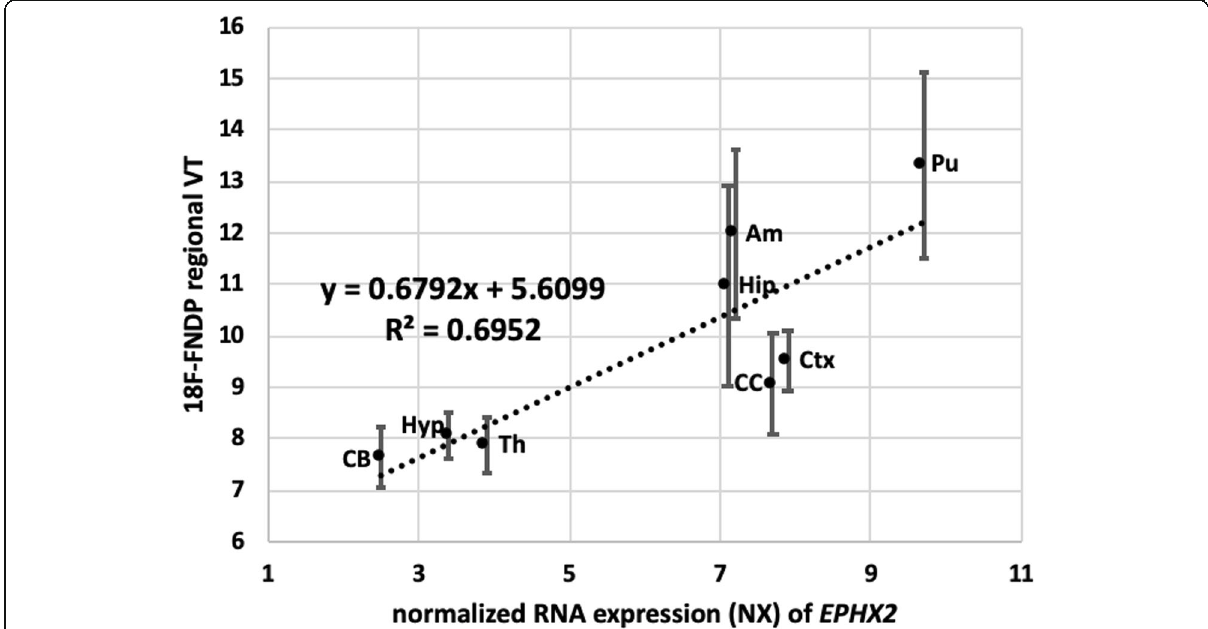
Fig. 7 Correlation of baboon regional V T values (Logan) for [ 18 F]FNDP vs. normalized mRNA levels (NX) for EPHX2 (HPA mouse brain RNA-seq dataset) [37, 38]. Abbreviations: Pu putamen, Ctx cortex, CC corpus callosum, Am amygdala, Hip hippocampus, Th thalamus, Hyp hypothalamus, CB